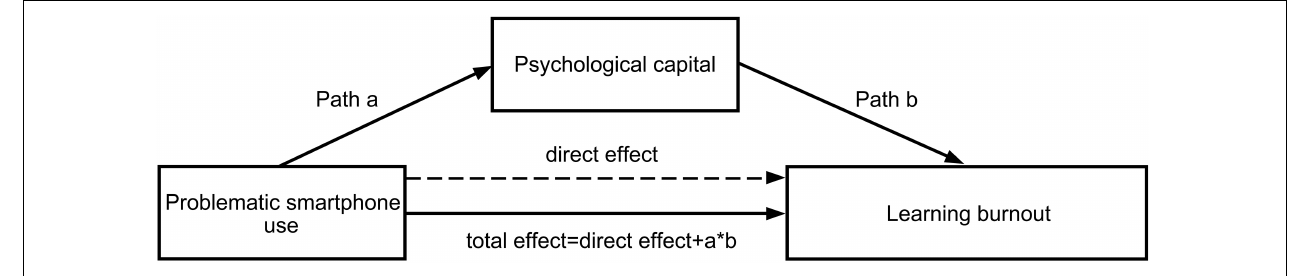
FIGURE 1 | The hypothetical theoretical model; note: a ∗ b, indirect effect as well as the mediating effect of psychological capital in this